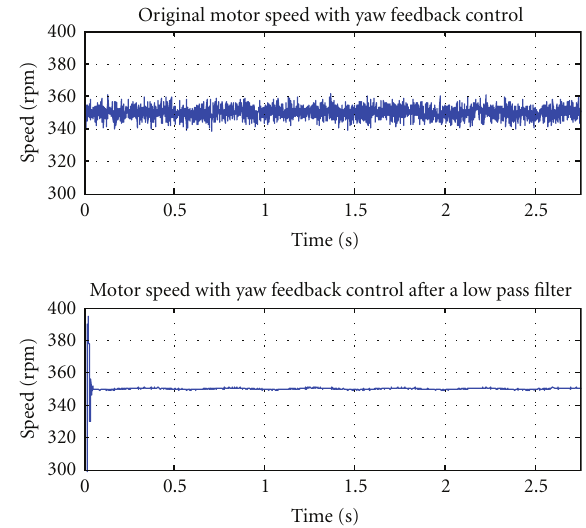
Figure 10: The measured yaw movement without and with yaw feedback control.